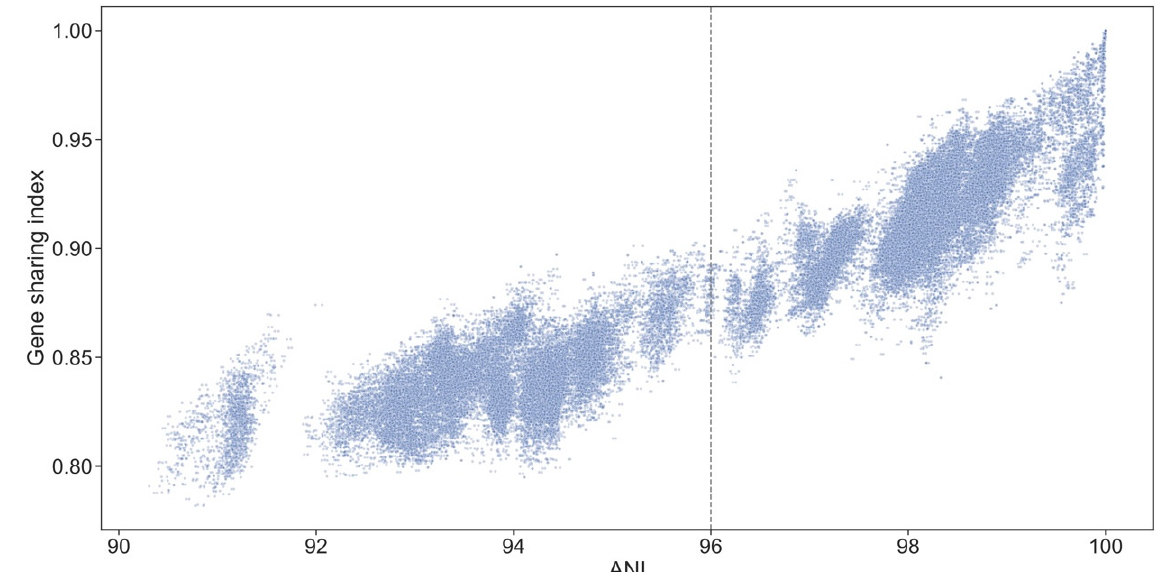
Figure 8. Sharing of accessory genes between strains compared to ANI. The gene sharing index is based on the number of orthogroups shared between two strains, normalized by total orthogroup content, for selected comparisons. See Figure S6. Dashed line at 96% ANI indicates approximate genospecies boundary.